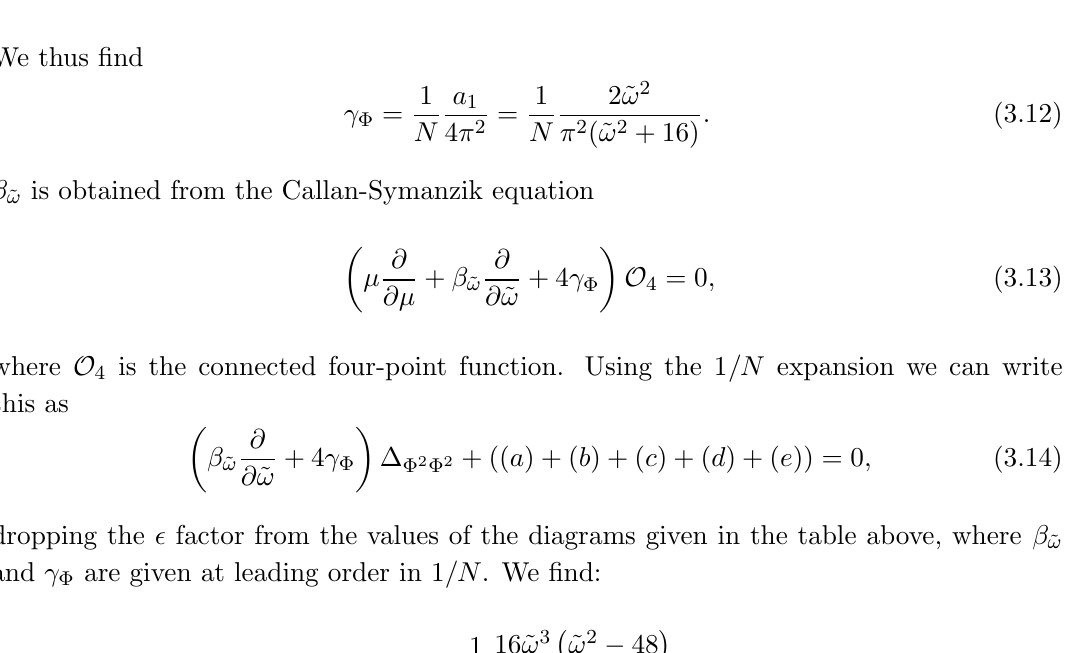
Table 1. The logarithmically diverging parts of the diagrams of (cid:12)gure